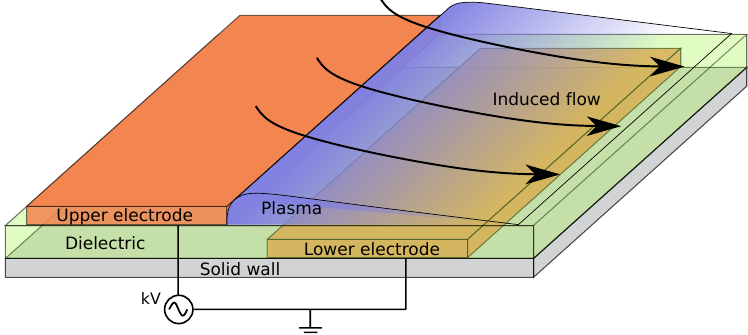
Figure 1. Schematic of a DBD